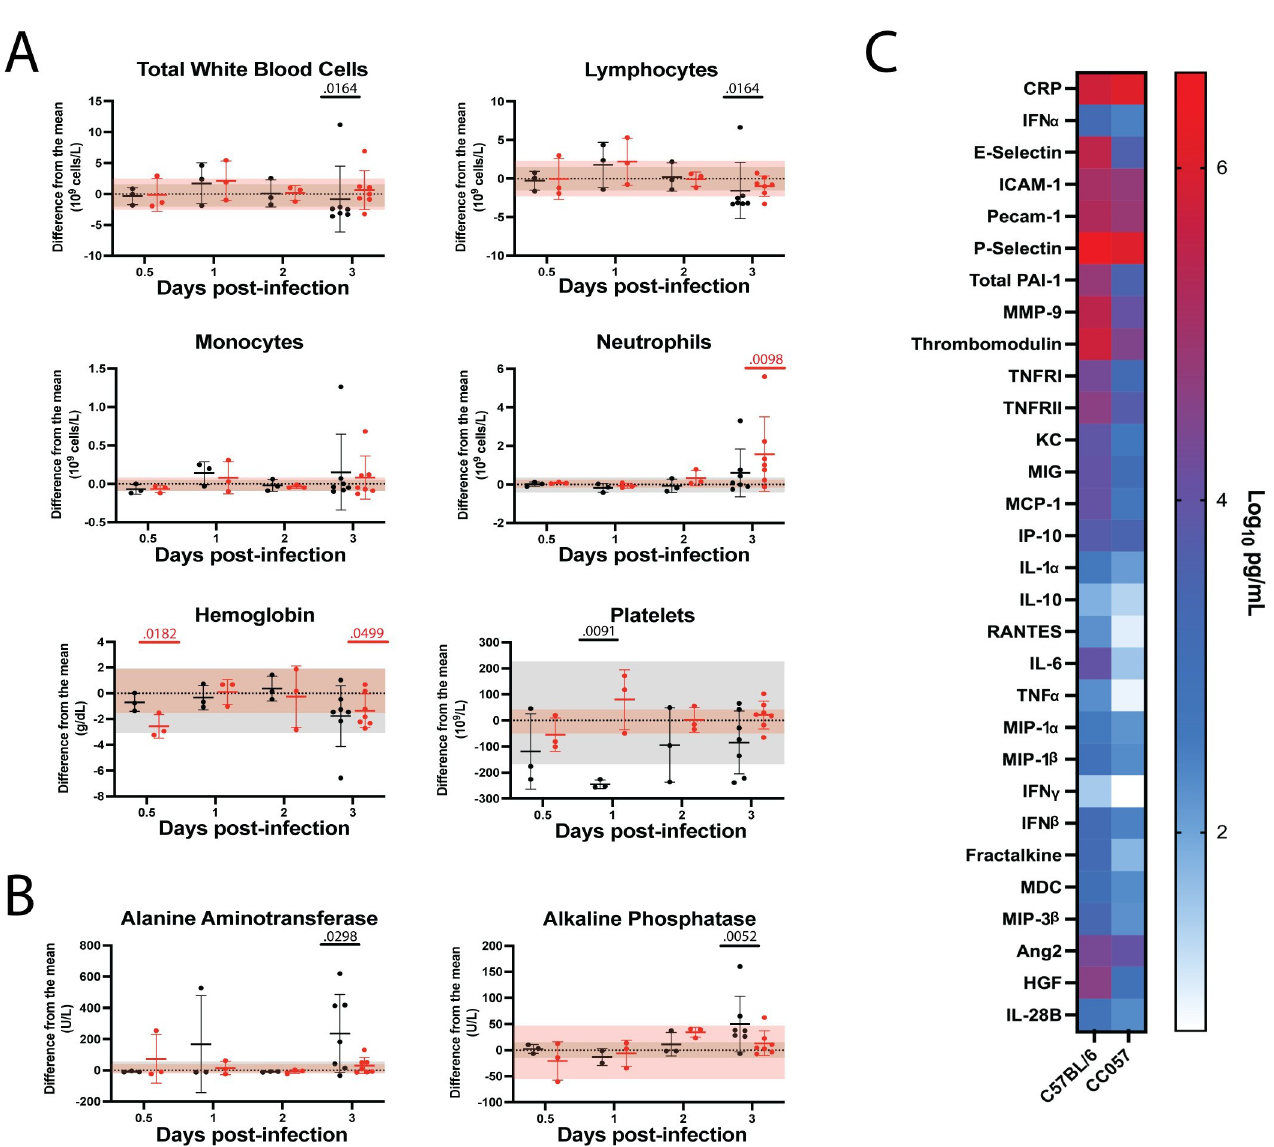
Fig 5. Acute phase blood biomarkers in C57BL/6 versus CC057 mice. A) CBC and B) CHEM over time with data presented as a function of difference from the uninfected mean, shown as mean ± SD (n = 3–7 mice/time point). Each data point shown represents an individual mouse. The uninfected means and normal ranges for C57BL/6 and CC057 mice were determined by performing CBC and CHEM on blood from 9 uninfected C57BL/6 mice and 9 uninfected CC057 mice. Uninfected normal ranges from the mean for C57BL/6 and CC057 mice are represented by grey and pink horizontal shading respectively. Comparisons of CBC data were performed at each timepoint by Mann-Whitney to compare RVFV-infected samples to uninfected control samples for each mouse strain separately (C57BL/6: Total white blood cells 3 dpi p = 0.0164; Lymphocytes 3 dpi p = 0.0164; Platelets 1 dpi p = 0.0091. CC057: Neutrophils 3 dpi p = 0.0098; Hemoglobin 0.5 dpi p = 0.0182, 3 dpi p = 0.0499). Comparisons of CHEM data were performed at each timepoint by Mann-Whitney to compare RVFV-infected samples to uninfected control samples for each mouse strain separately (C57BL/6: ALT 3 dpi p = 0.0298; ALP 3 dpi p = 0.0052). C) Analyte levels in the plasma at 3 dpi. Data shown as the mean (C57BL/6 n = 15; CC057 n = 3).